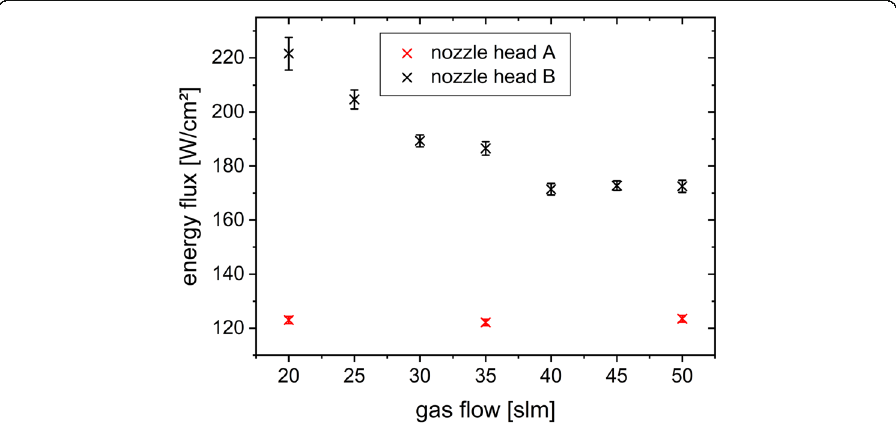
Fig. 5 Influence of the amount of gas on the energy flux from nozzle head A (primary voltage: 400 V). The distance of the excitation volume to the probe was set to 20 mm, corresponding to a distance of 4 mm between probe and nozzle for head